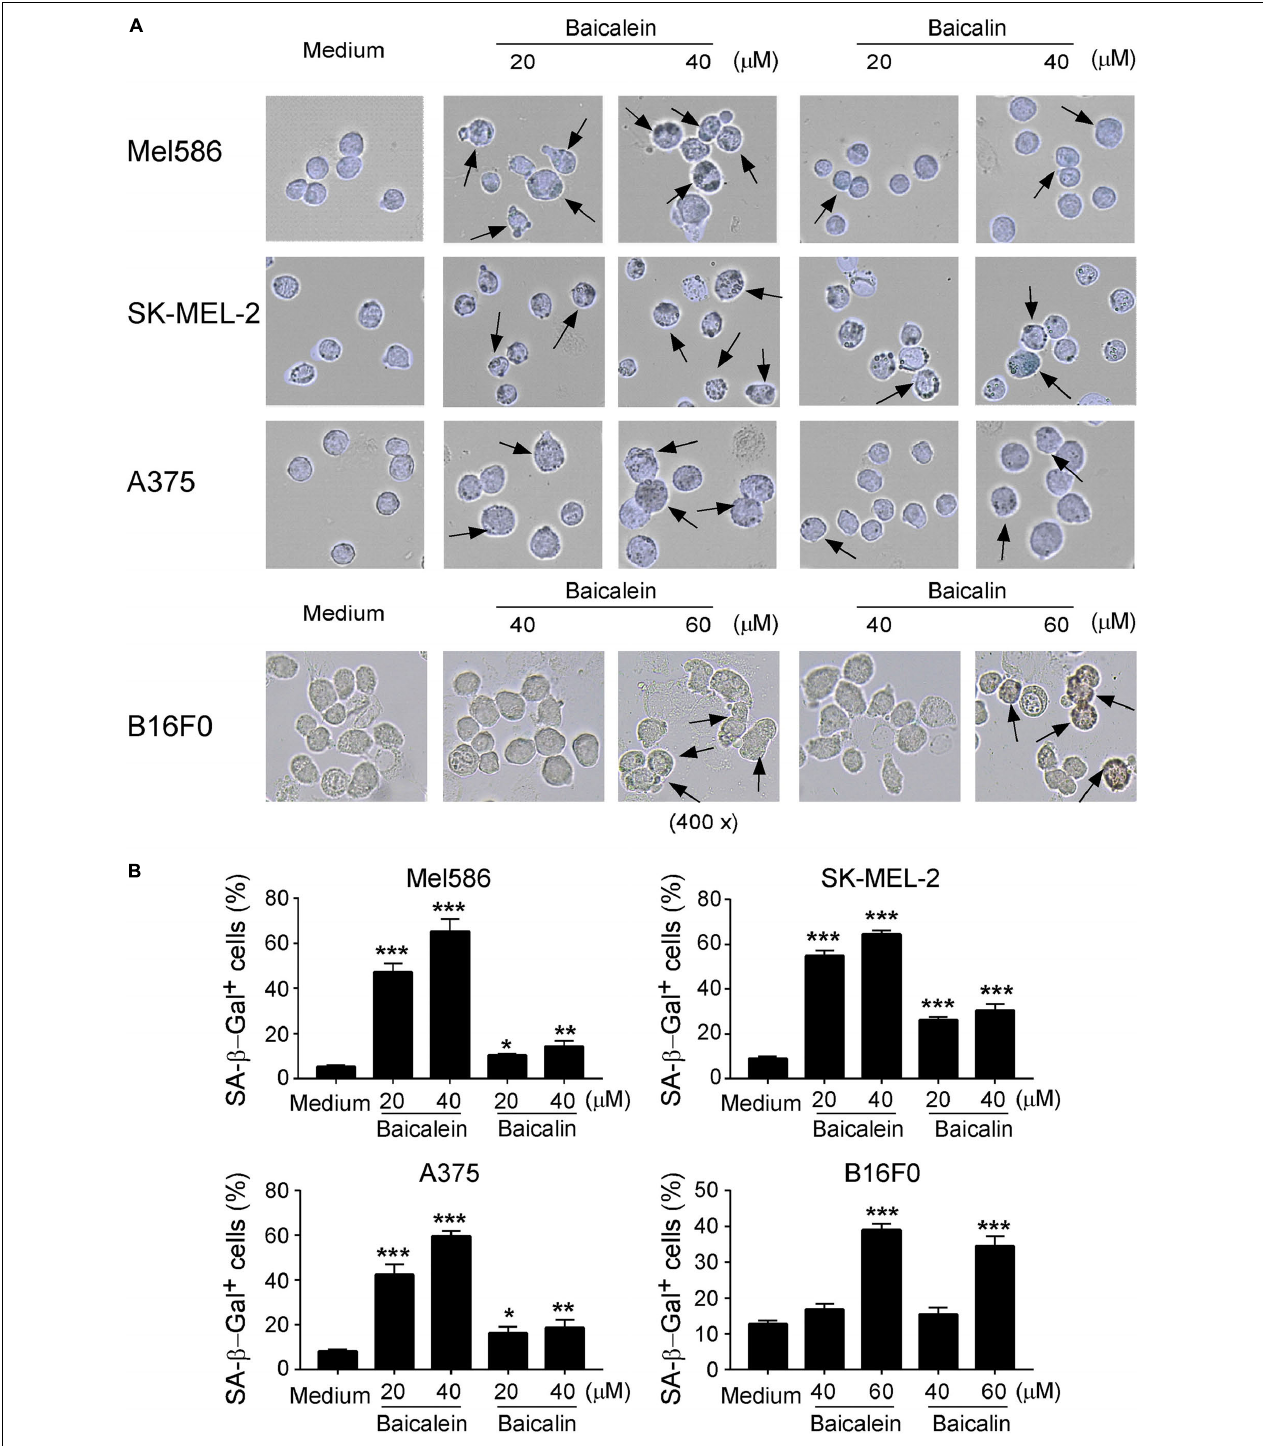
FIGURE 4 | Baicalein and baicalin treatments induce melanoma cell senescence. (A,B) Increased senescent cell populations were induced in human and mouse melanoma cells after treatments with baicalein and baicalin. Tumor cells were cultured in the presence of indicated concentrations of baicalein and baicalin for 72 h. Senescent cells were analyzed using the SA- β -Gal activity assay and the SA- β -Gal positive cells were identified with dark blue granules as indicated by the arrows (A) . Data in panel (B) are mean ± SD from three independent experiments with similar results. * p < 0.05, ** p < 0.01, and *** p < 0.001, compared with the medium control